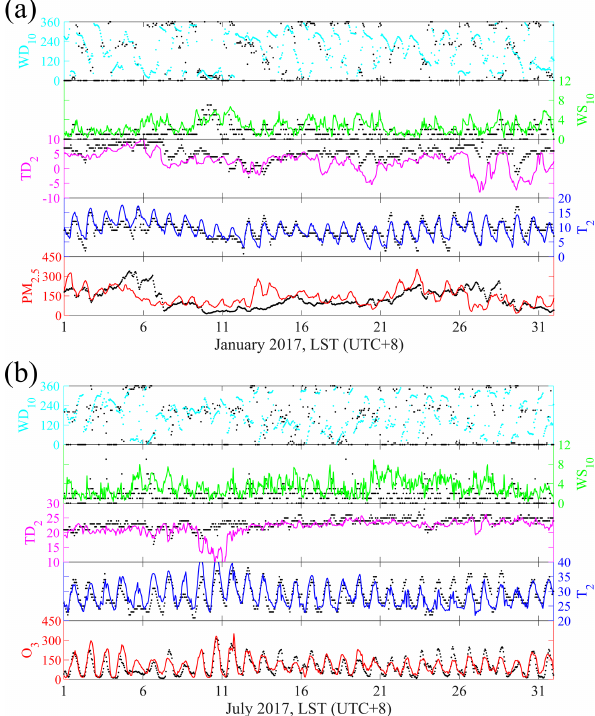
Figure 6. (a) Times series of PM 2 . 5 , T 2 , TD 2 , WS 10 and WD 10 for January 2017. (b) Times series of O 3 , T 2 , TD 2 and WS 10 and WD 10 for July 2017. The black dots are observations. The colored lines and cyan dots are simulated values from the baseline